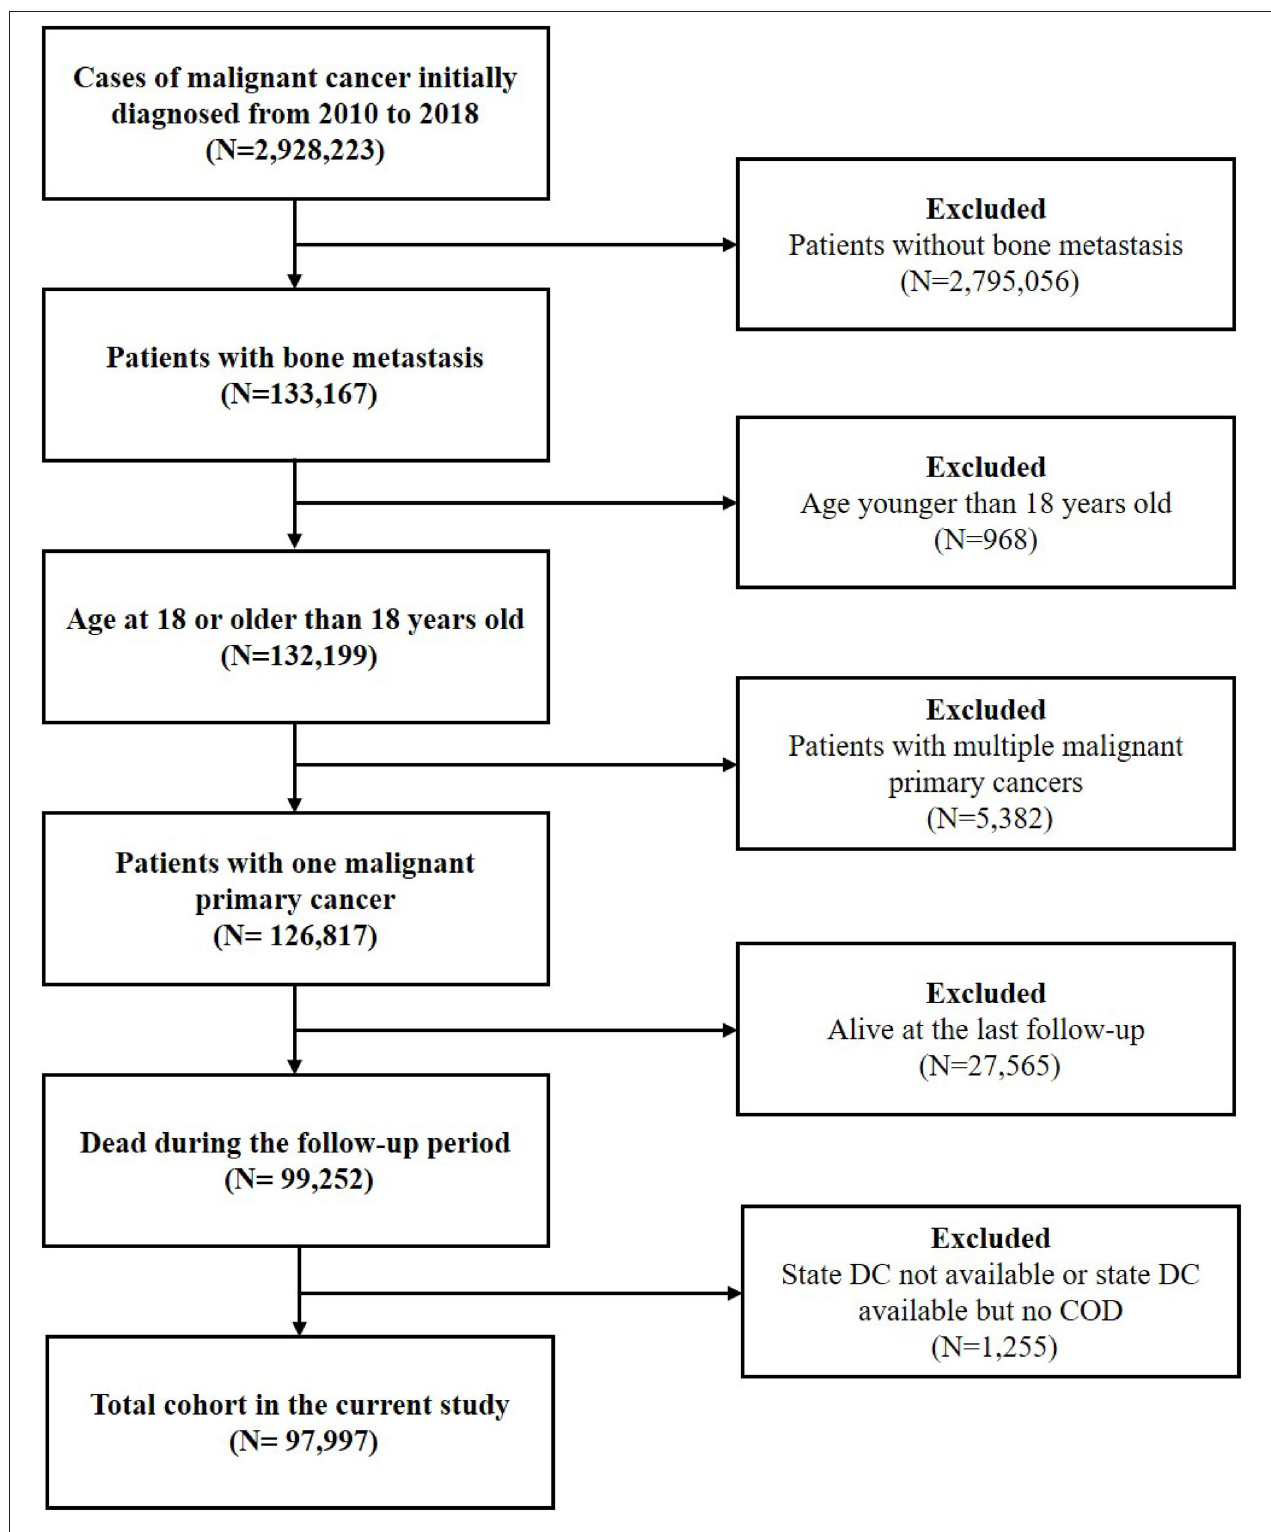
FIGURE 1 | The flowchart of the present